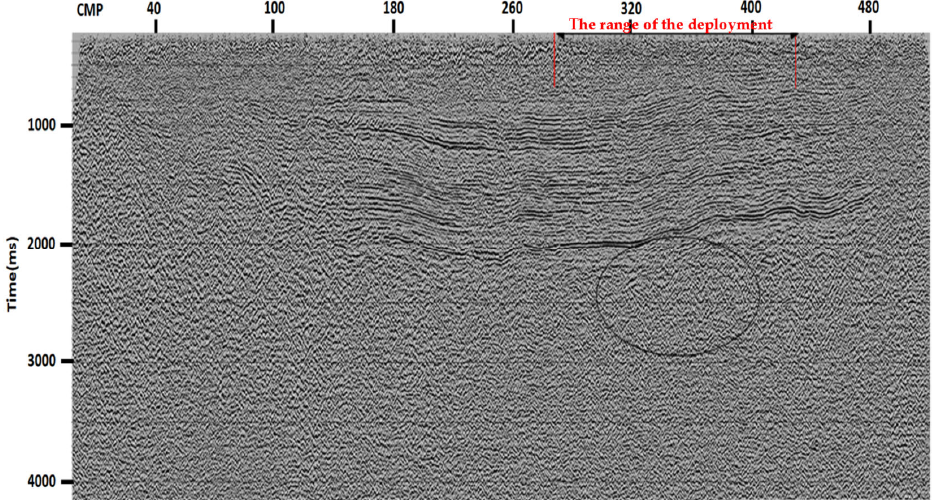
Figure 11. The section of a dry ‐ hot rock development area in Gonghe Basin.